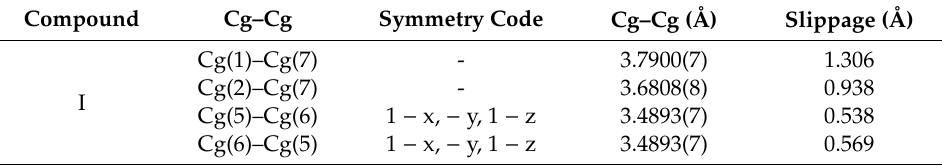
Table 4. π – π stacking interactions displayed by